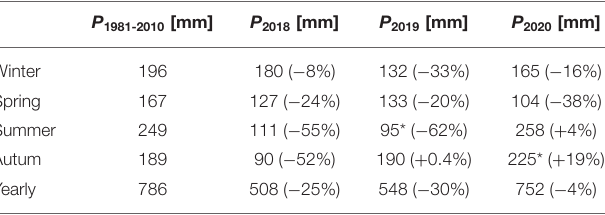
TABLE 1 | Precipitation data for the reference period (1981–2010) and the seasons of 2018, 2019, and 2020 from the DWD weather station ID 4548 (Data obtained from the climate data center of the German Meteorological Society (DWD, 2021)).